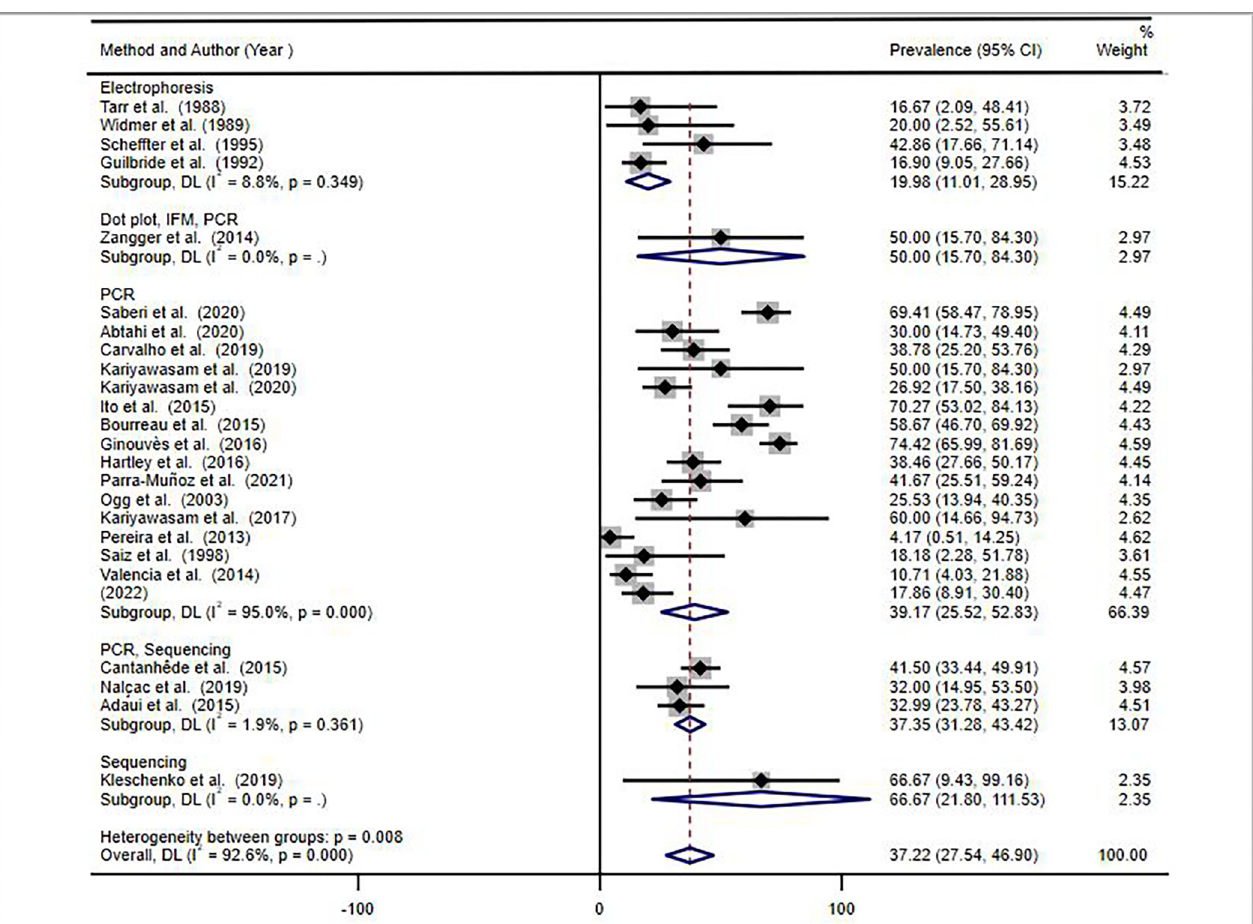
Fig 5. Forest plot showing the pooled LRV prevalence estimate by geographical region in Leishmania parasites and/or lesions of patients with cutaneous leishmaniasis, 2021.